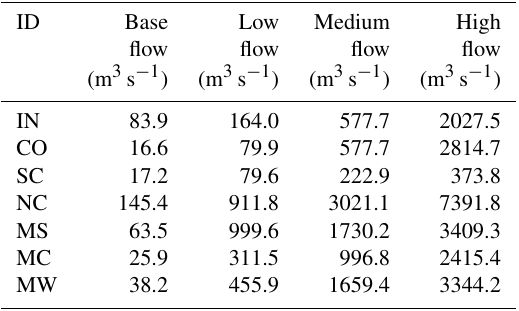
Table 2. Base flow and low, medium, and high flow rates for each study site.